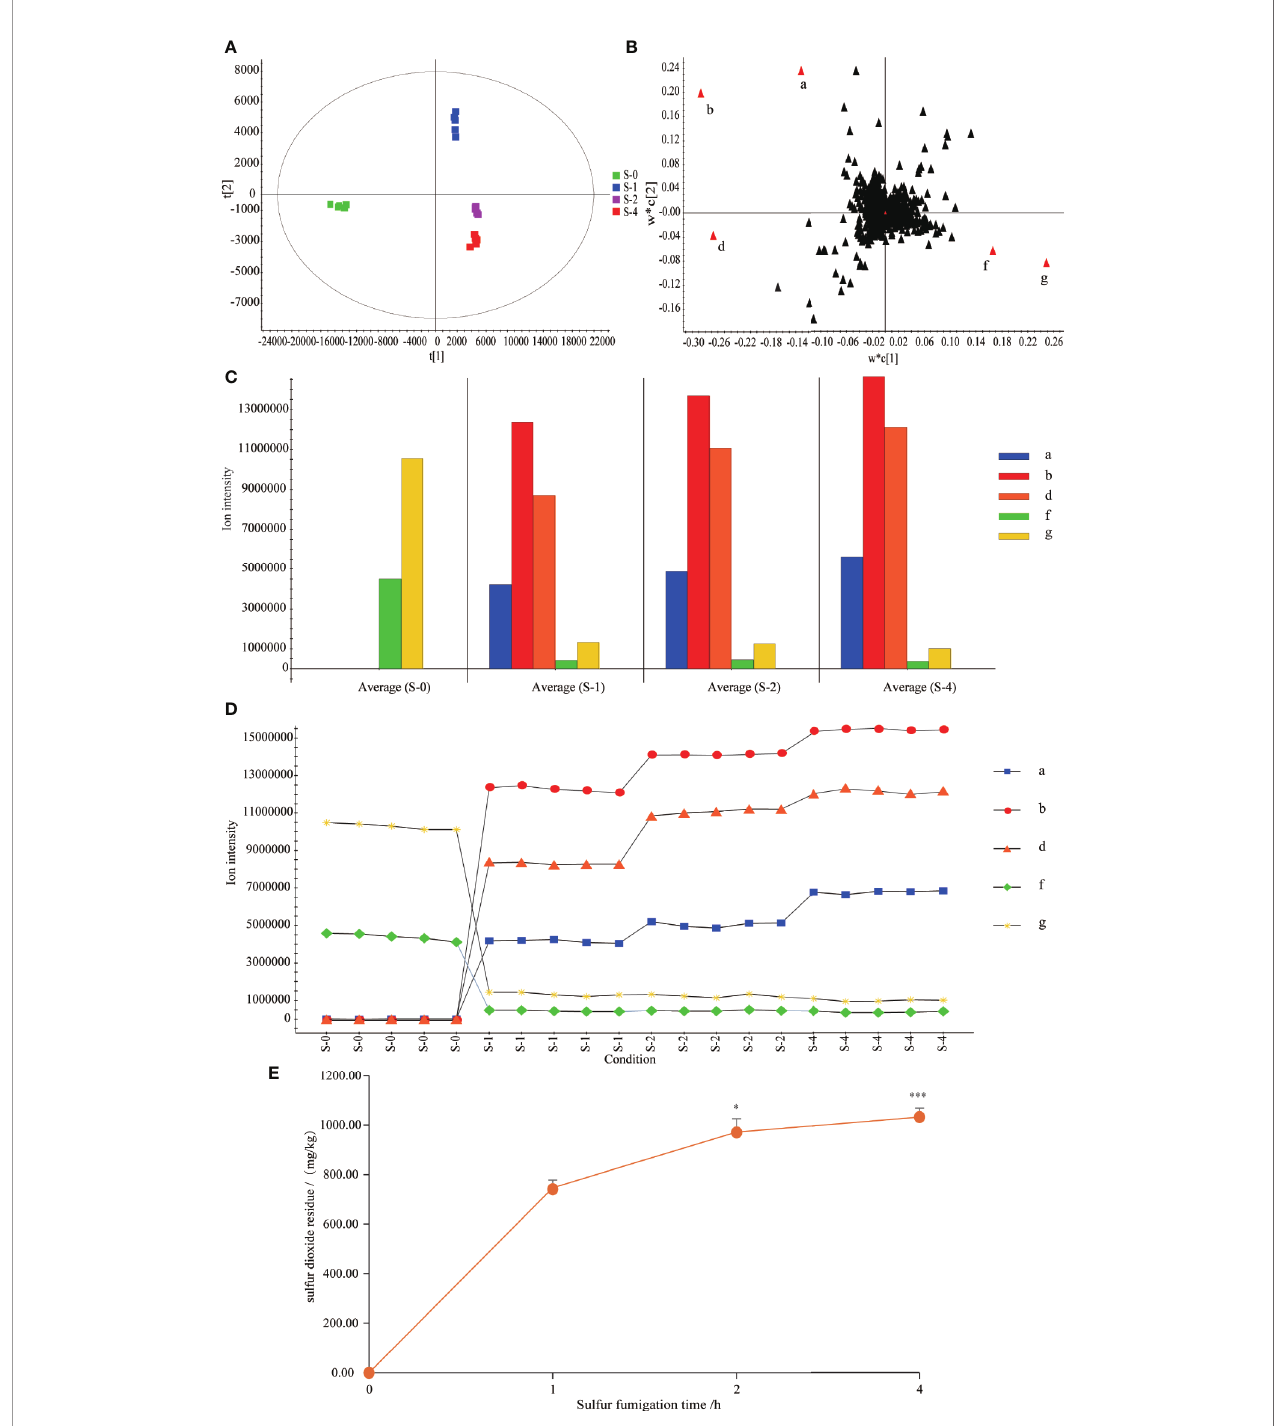
FIGURE 5 | Content variations of the fi ve markers and sulfur dioxide residue in the TR samples within 4 h sulfur-fumigation. (A) PCA/scores plot; (B) Loading score; (C) column plot of the ion intensity; (D) ion intensity variations of the fi ve markers in 4 h; (E) content variations of sulfur dioxide residue in sulfur-fumigation process. *** p <0.001, compared with 1 h; * p <0.05, compared with the 1